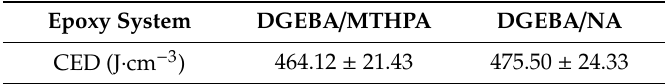
Table 2. The cohesive energy density (CED) of the epoxy system.